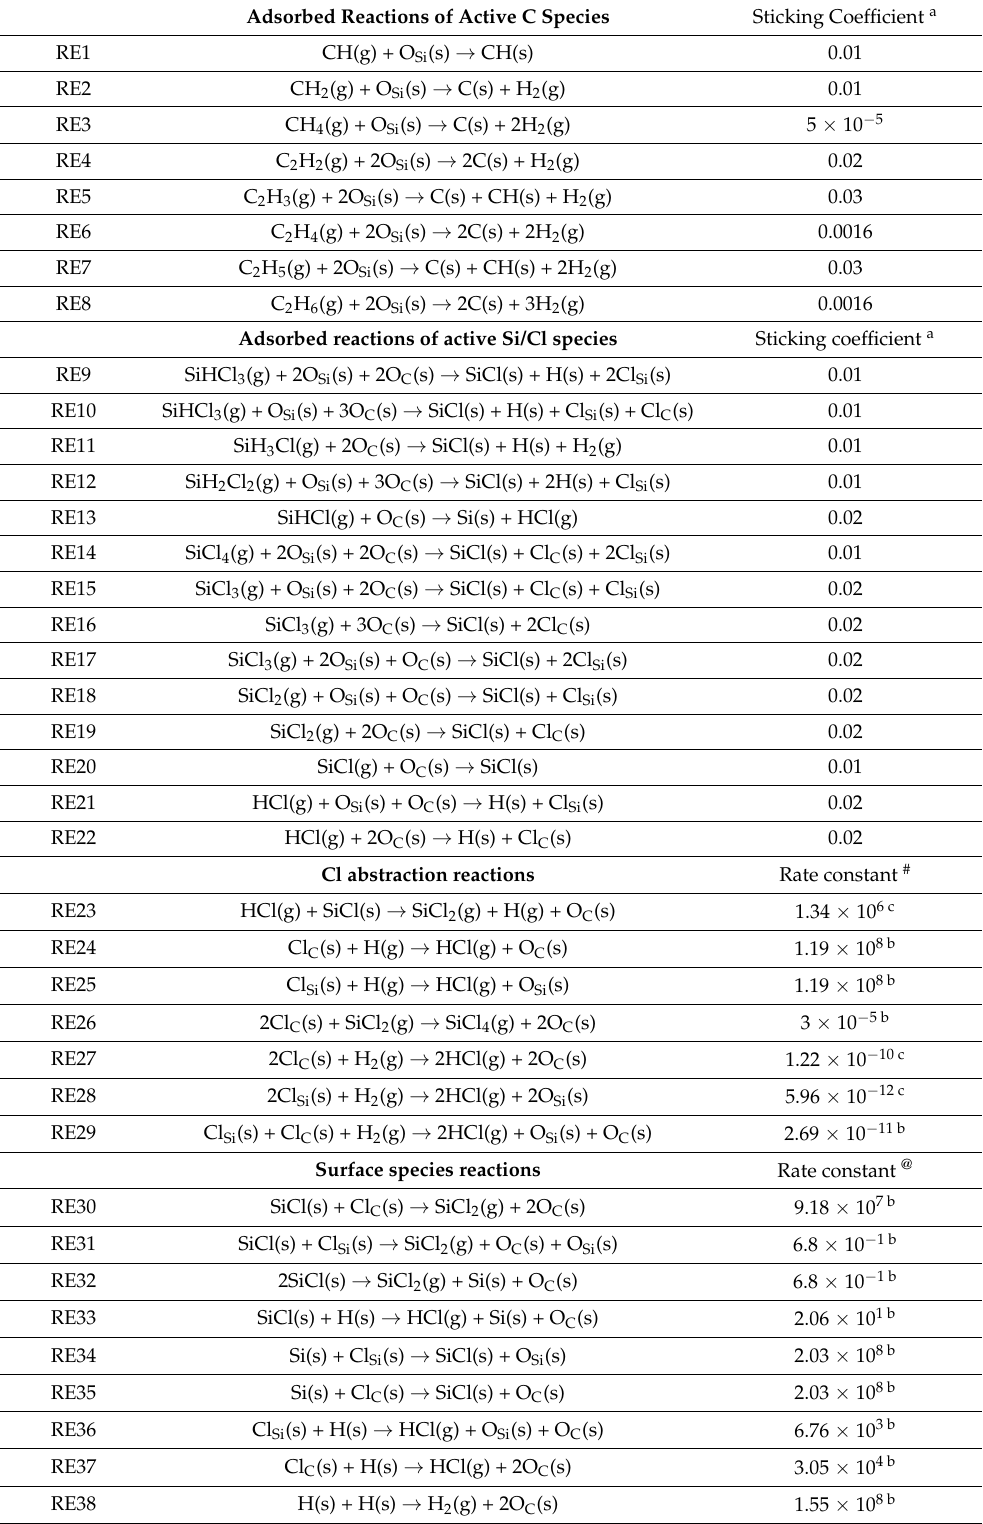
Table 4. Surface reaction mechanism for SiC from H-Si-C-Cl